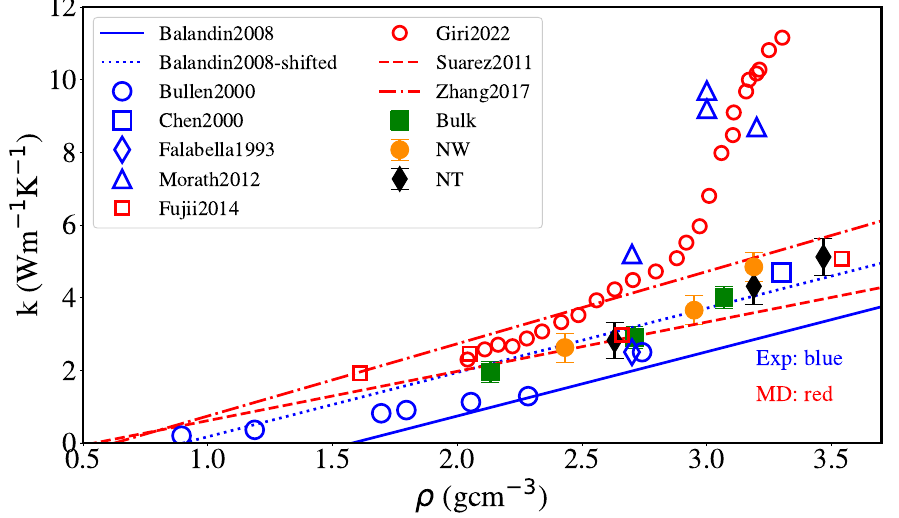
Figure 12. Thermal conductivity at 300 K vs. density ρ for different geometries (NT internal ra- dius is 1 nm). The solid line shows the fit to aC thin-film experiments by Balandin et al. [31], k = − 2.82 + 1.77 ρ . The dashed line shows the fit to the MD results by Suarez-Martinez and Marks [44], k = − 0.74 + 1.36 ρ , and the dotted-dashed black line shows the fit to MD results using the Tersoff potential [42], k = − 1.25 + 1.99 ρ . The dotted line shows the previous fit by Balandin et al. shifted 0.8 Wm − 1 K − 1 upwards. Experimental results in blue include circles [30], empty squares [33], diamonds [98] and triangles [34], and are shown together with MD results in red, including empty squares for AIREBO [97] and circles for extended Tersoff